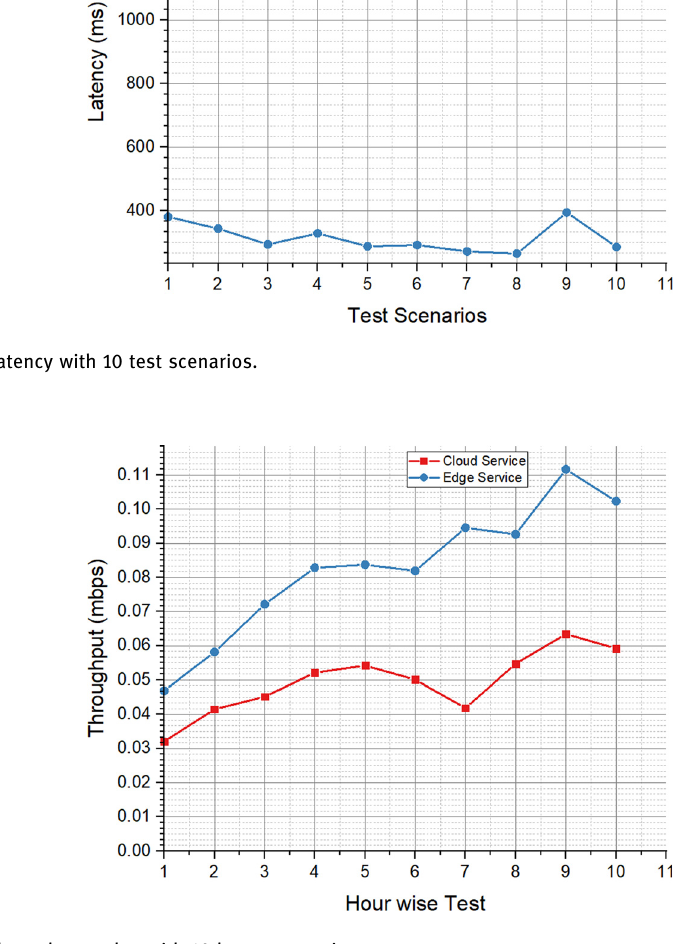
Figure 9: Average throughput value with 10 h test scenarios.